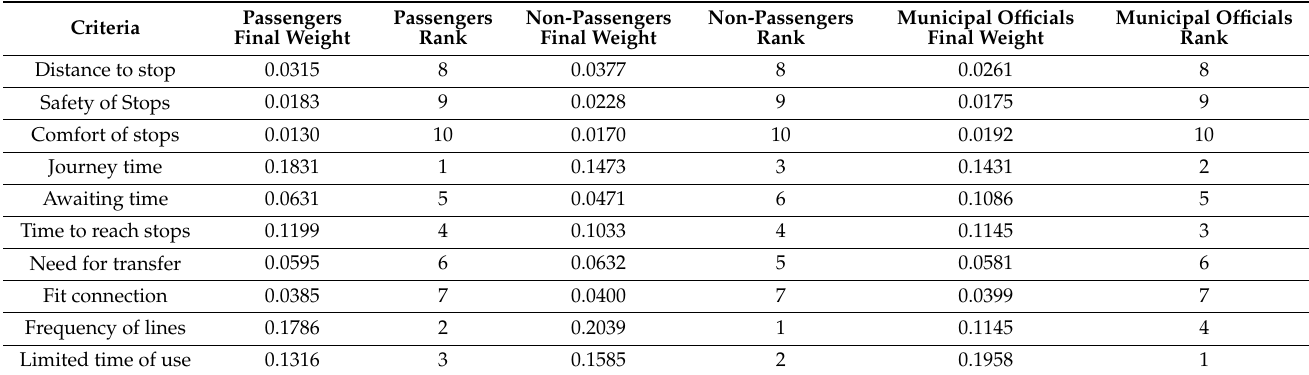
Table 4. Stakeholders final weight score for level